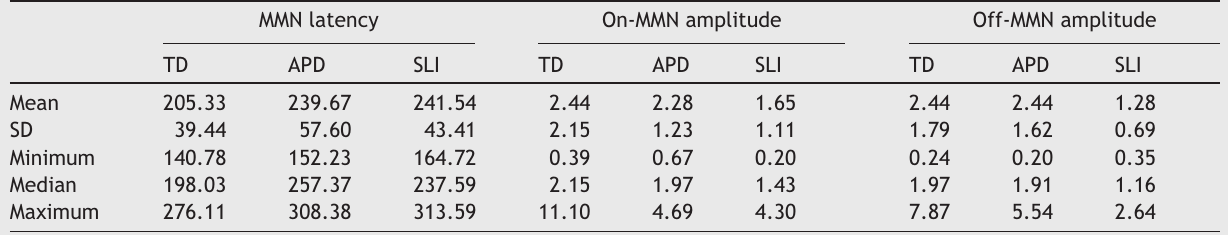
Table 1 Descriptive statistics for the mismatch negativity (MMN) response values, considering the measures of latency and amplitude for all three